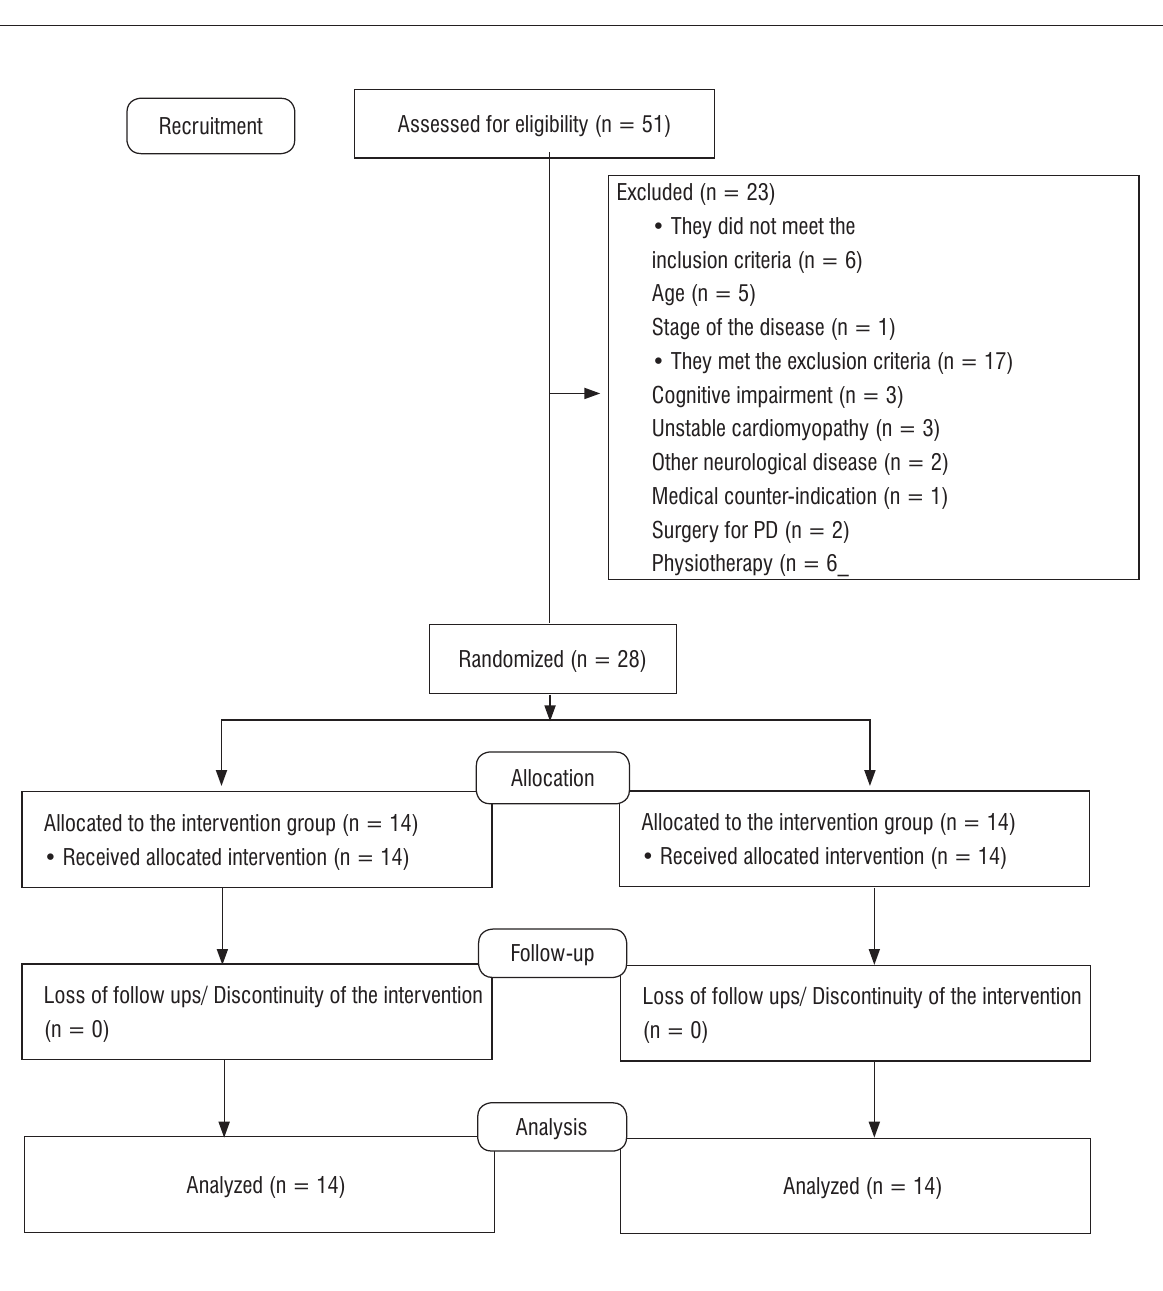
Figure 1 - Sample